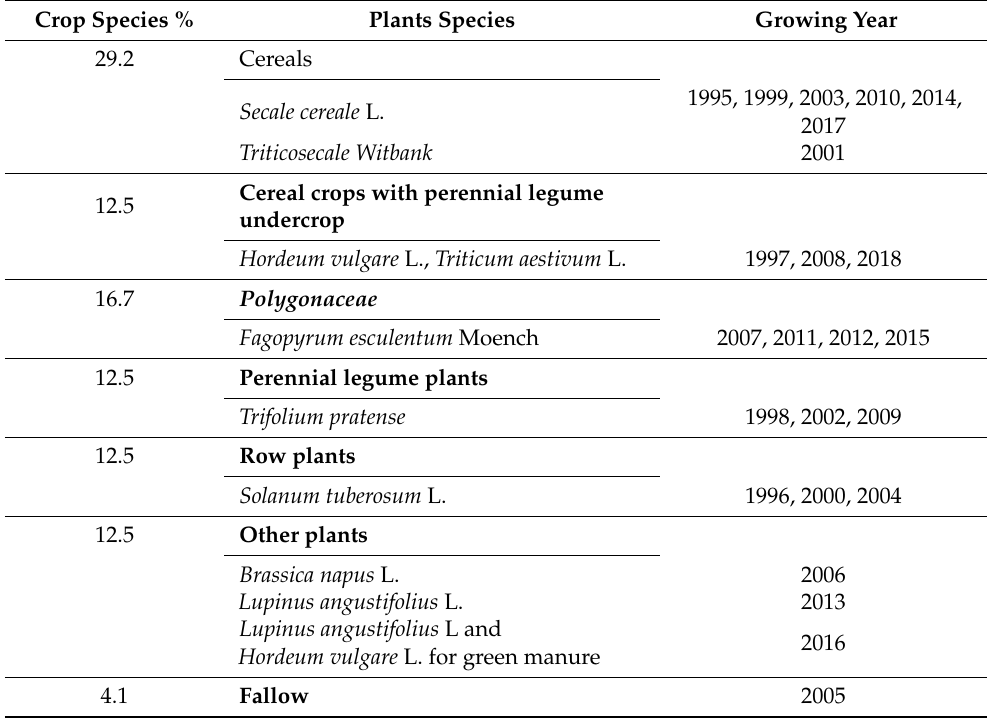
Table 1. Crop rotation plants during 1995–2018. Crop Species